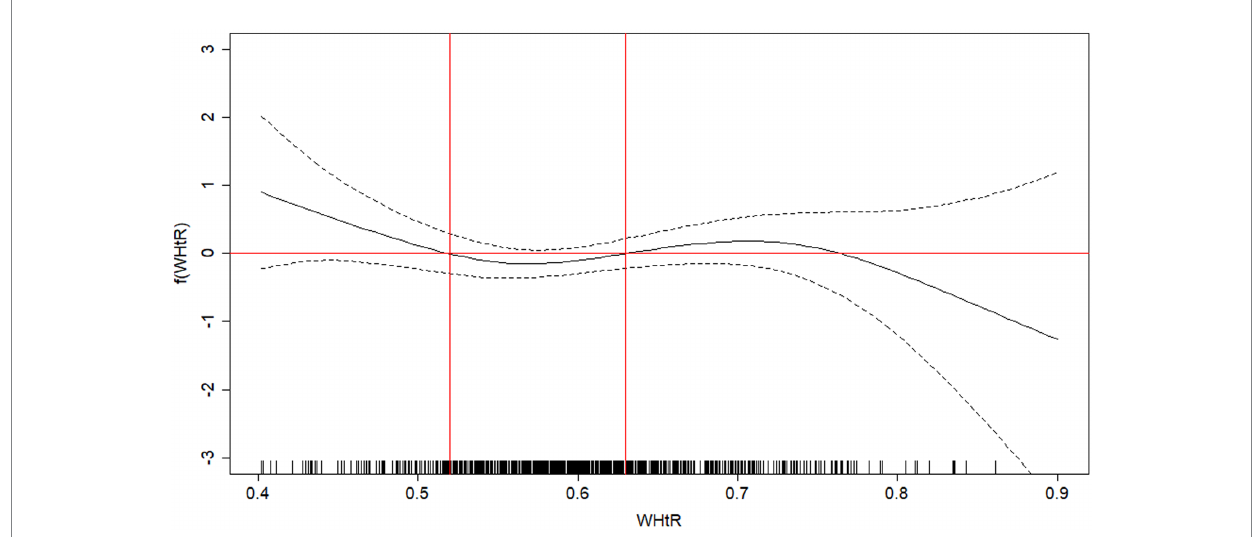
FIGURE 1 Attenuated function of mortality in older adults as a function of waist-to-height ratio (WHtR). Viçosa, MG, Brazil, 2009 -2018. The solid black line represents the regression line, and the dotted lines represent the 95% confidence interval. Cutoff points for WHtR = <0.52; between 0.52 and 0.63; ≥0.63.